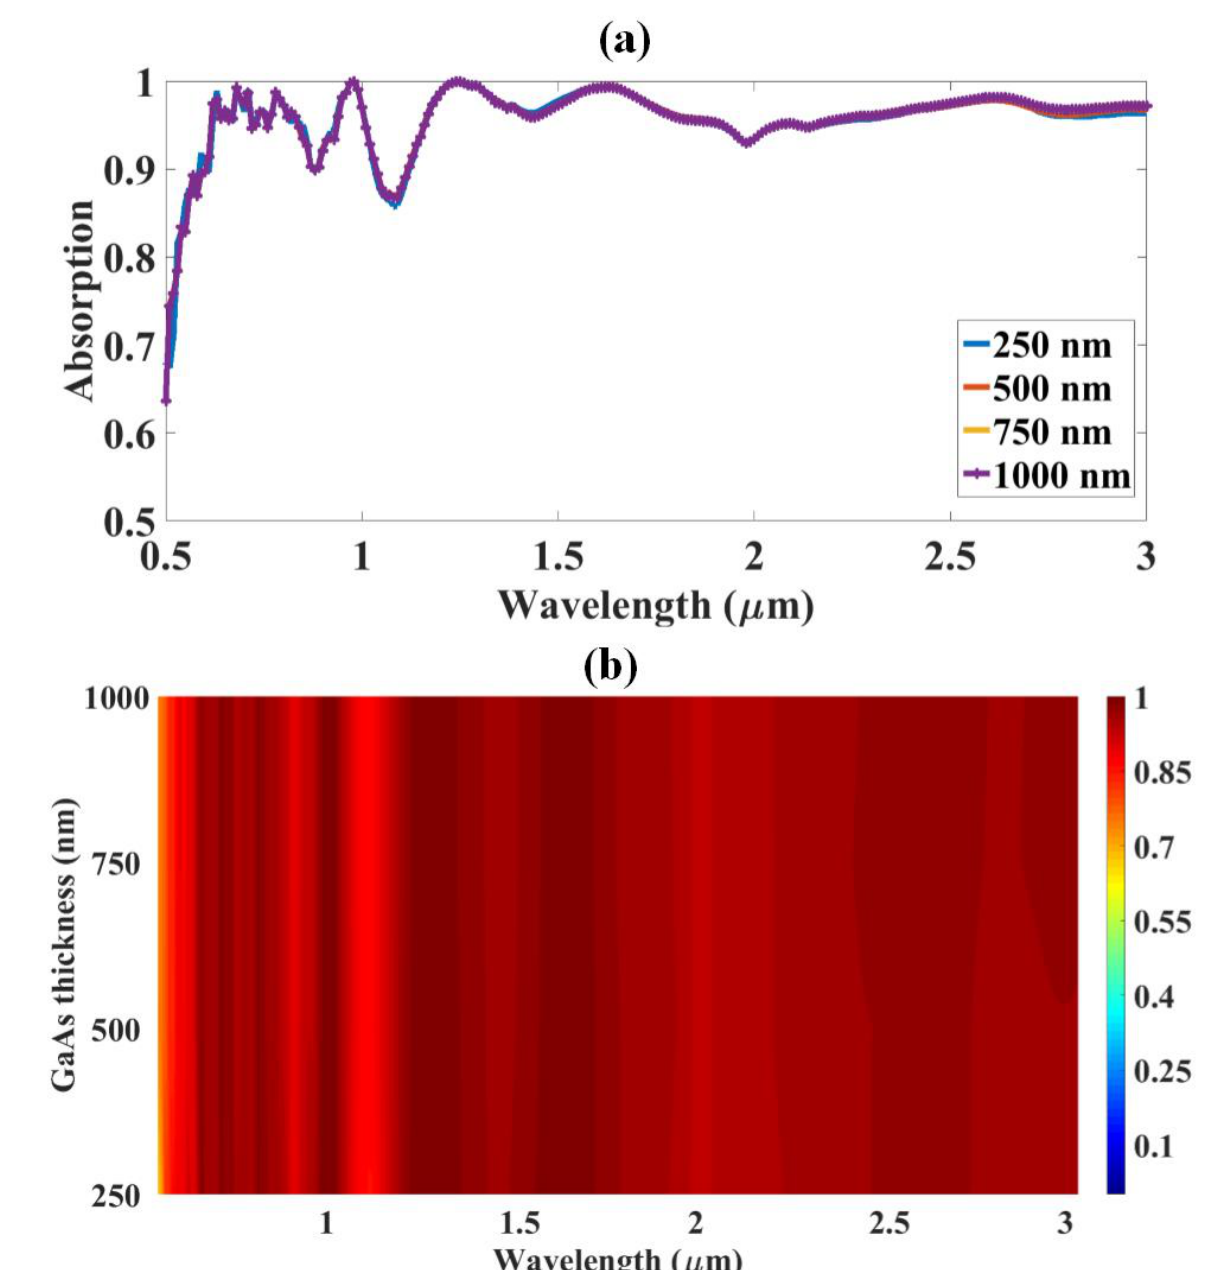
Figure 5. The impact of GaAs thickness change on absorption is shown in ( a ) the absorption response for 250 nm to 1000 nm GaAs thickness variation in a line plot and ( b ) the absorption response for 250 nm to 1000 nm variation in a color plot, with the red color having the highest absorption. The absorption is nearly constant across the entire range of GaAs material thickness variations.